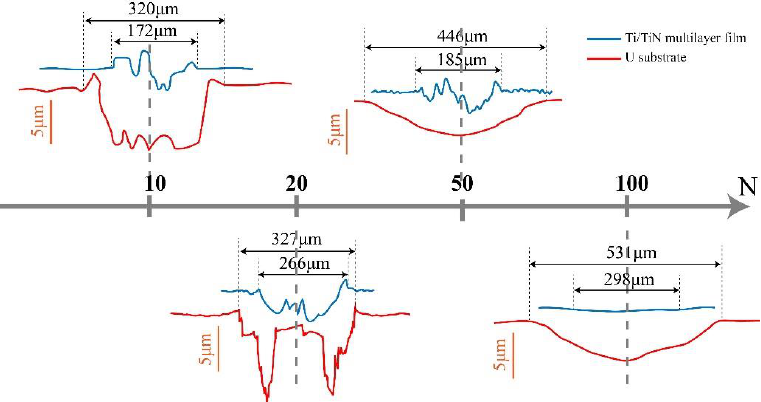
Figure 9. Wear profiles of uranium and the Ti/TiN multilayer film at different normal loads.